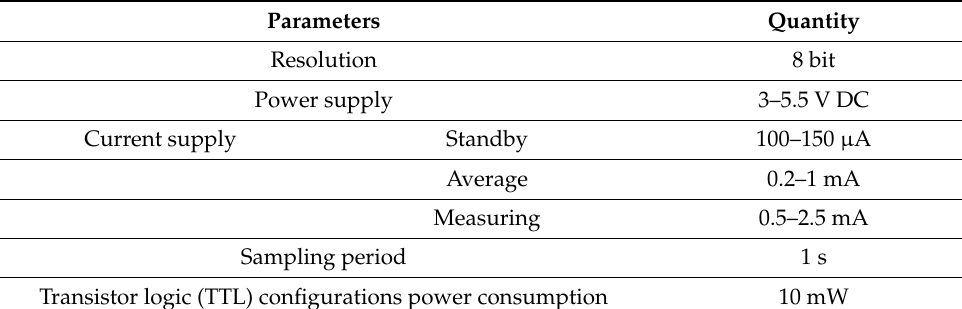
Table 1. Power consumption of DHT11.